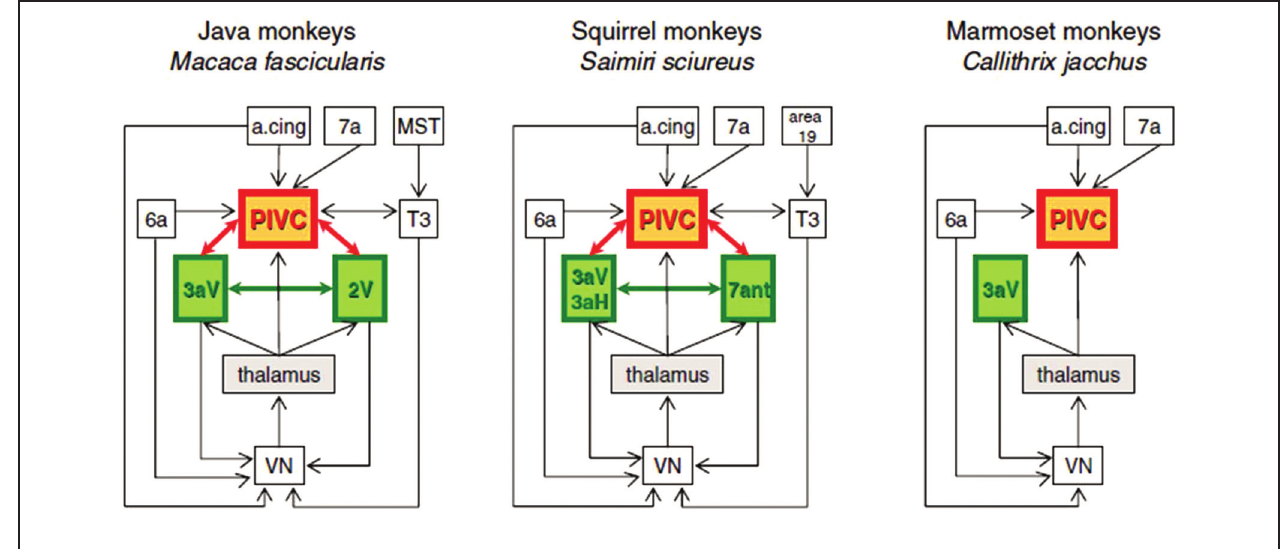
sciureus and marmoset monkeys, Callithrix jacchus ). A cing: anterior cingulate region. PIVC: parieto-insular vestibular cortex. MST: medial superior temporal area. Reproduced from Lopez and Blanke (2011) with